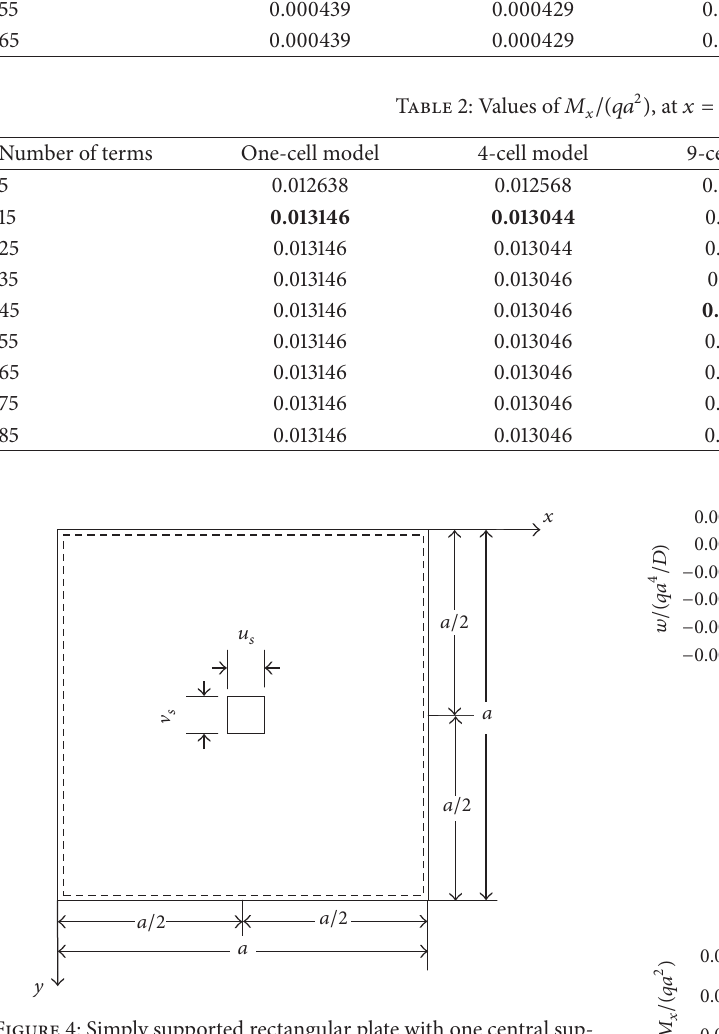
Figure 4: Simply supported rectangular plate with one central sup- port.